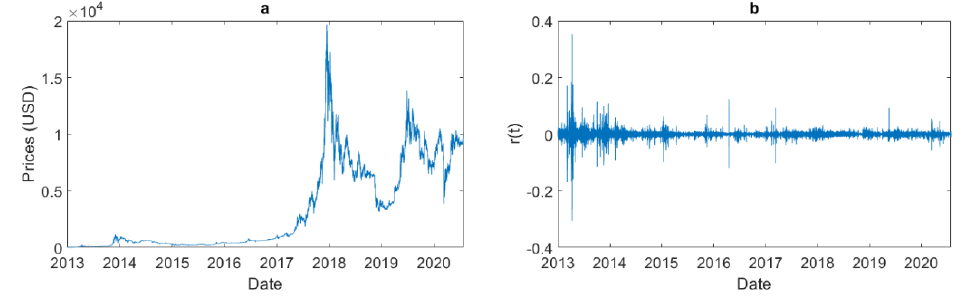
Figure 2. One minute bitcoin prices ( a ) and one minute bitcoin returns ( b ).